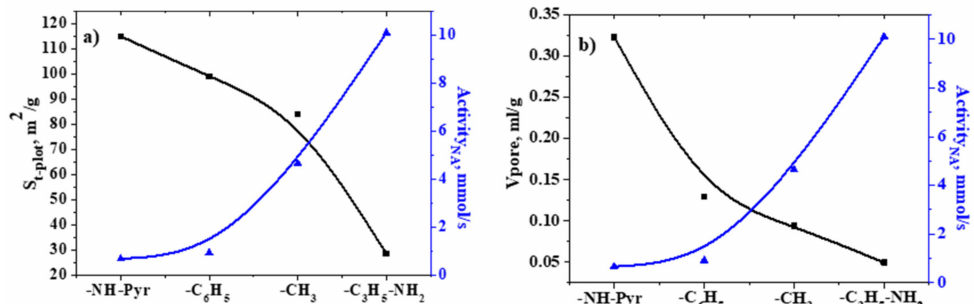
Figure 11. The relationship between the activity of deposited palladium in hydrogenation of p-nitroaniline and ( a ) the specific surface area of their supports, ( b ) the nature of the functional